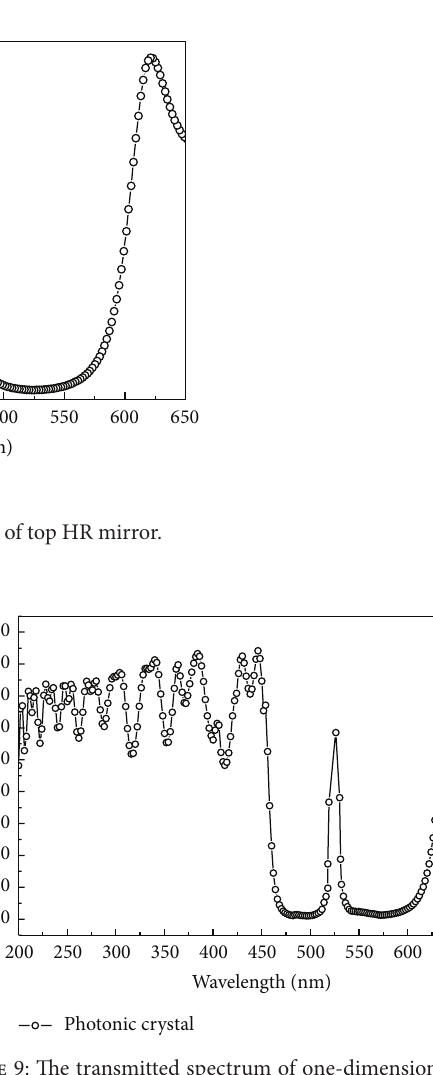
Figure 8: The transmitted spectrum of bottom HR mirror.